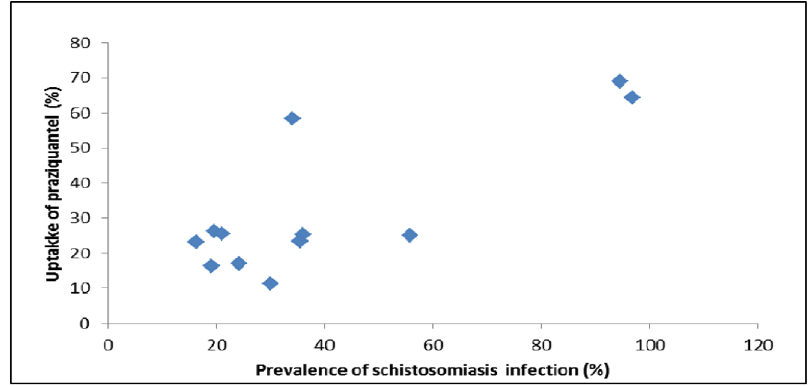
Figure 1. Comparison between uptake of praziquantel and prevalence of S.mansoni . doi:10.1371/journal.pone.0063438.g001 PLOS ONE |